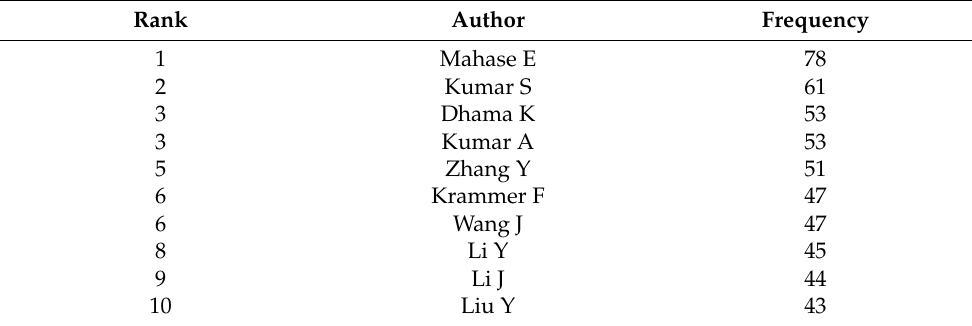
Table 1. The top 10 authors of publications on COVID-19 vaccines.